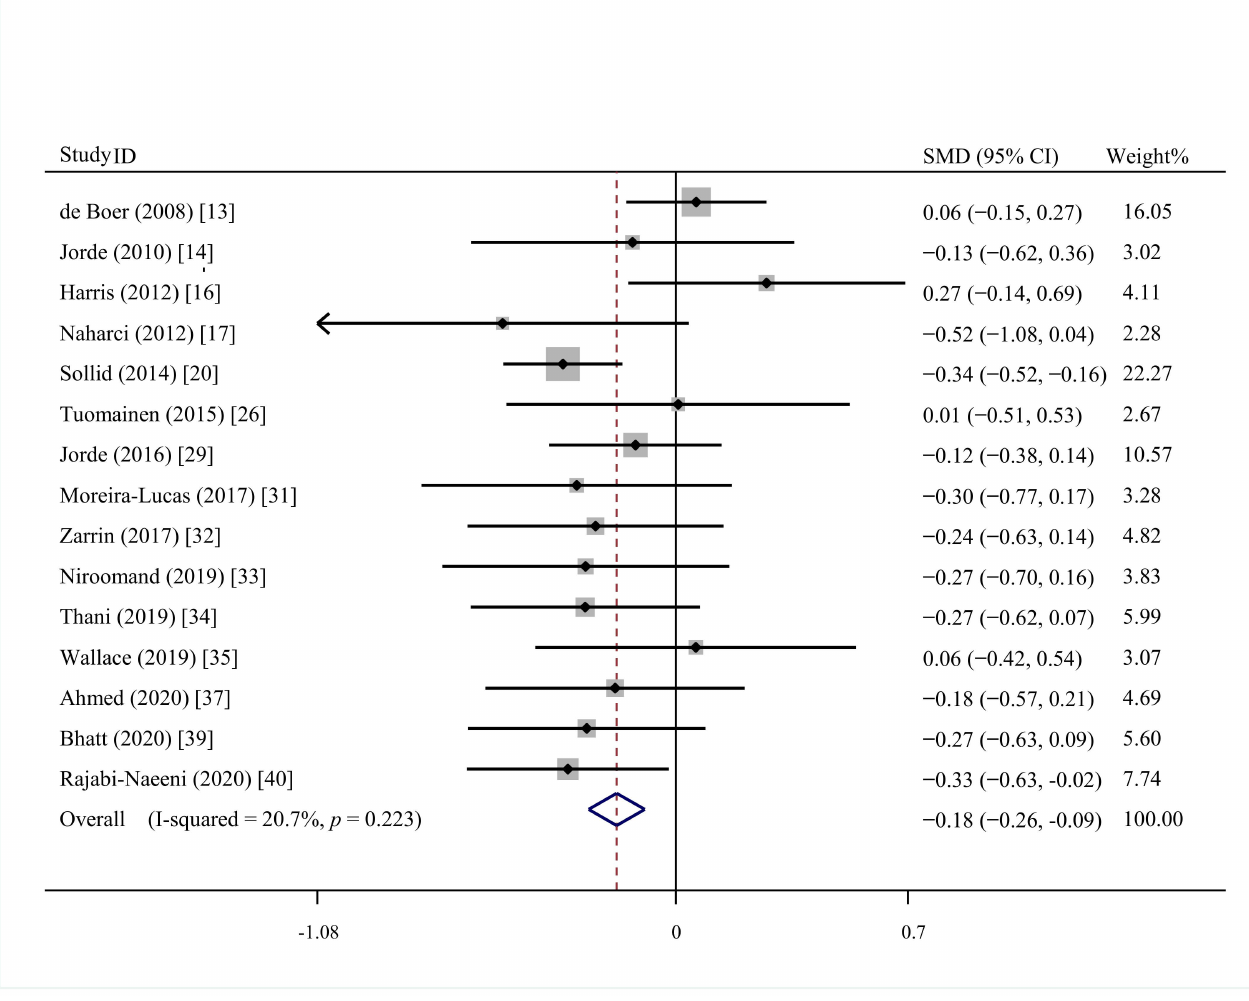
Figure 4. Effect of vitamin D supplementation on fasting serum insulin in